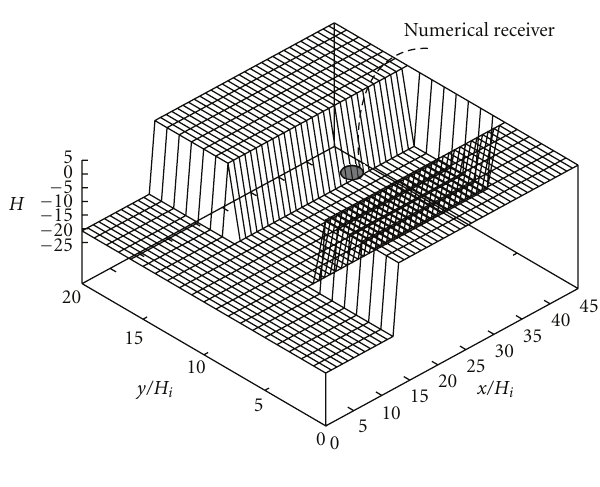
Figure 7: Small harbour